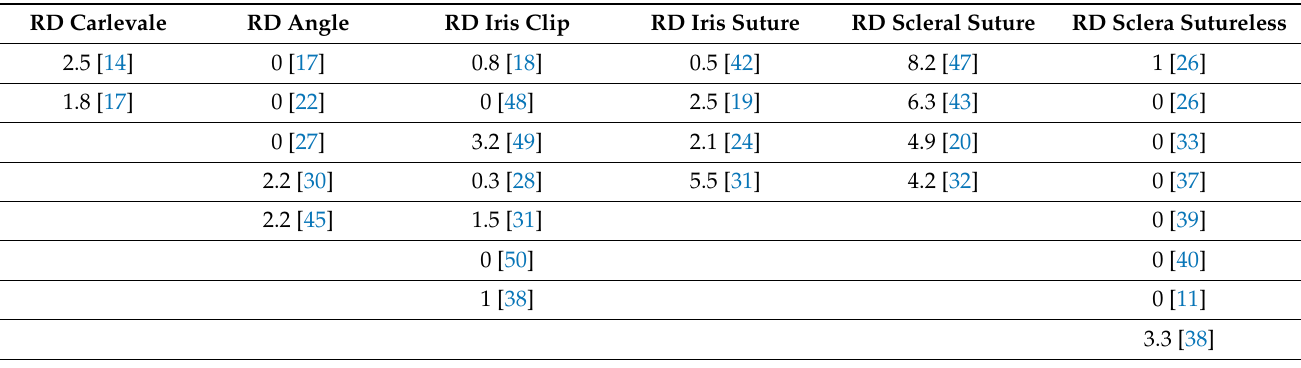
Table 6. Retinal detachment incidence of complications of different